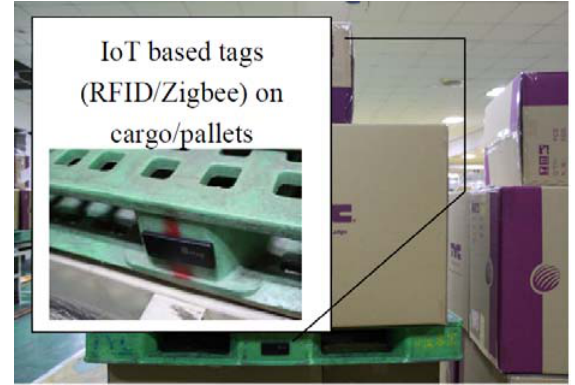
Figure 2. IoT-technology-enabled logistic scenario. RFID and barcode tags on cargo at the same time